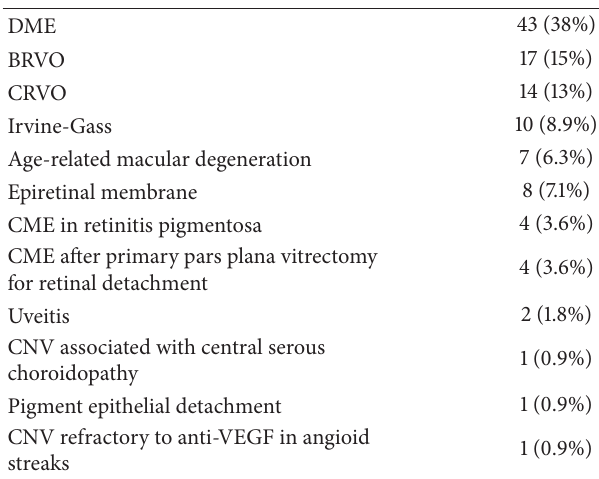
Table 2: Causes of macular